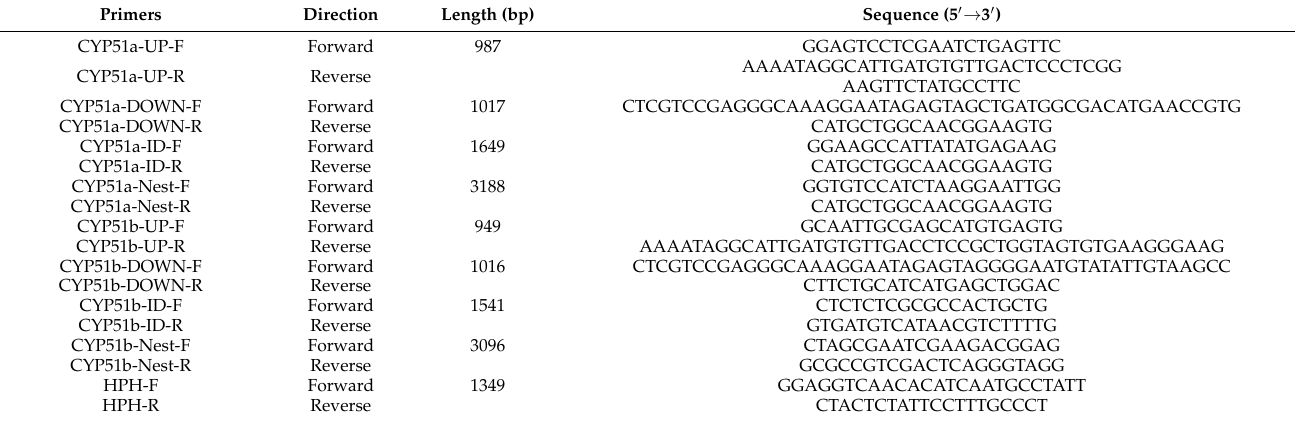
Table 1. Primers used in this